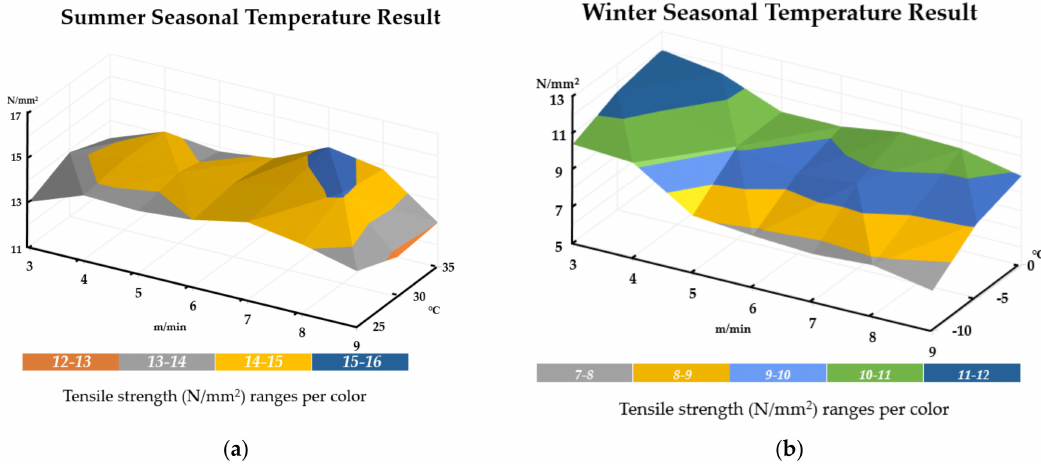
Figure 11. Comparative results showing tensile strength changes relative to welding speed and temperature: ( a ) summer season condition, and ( b ) winter season